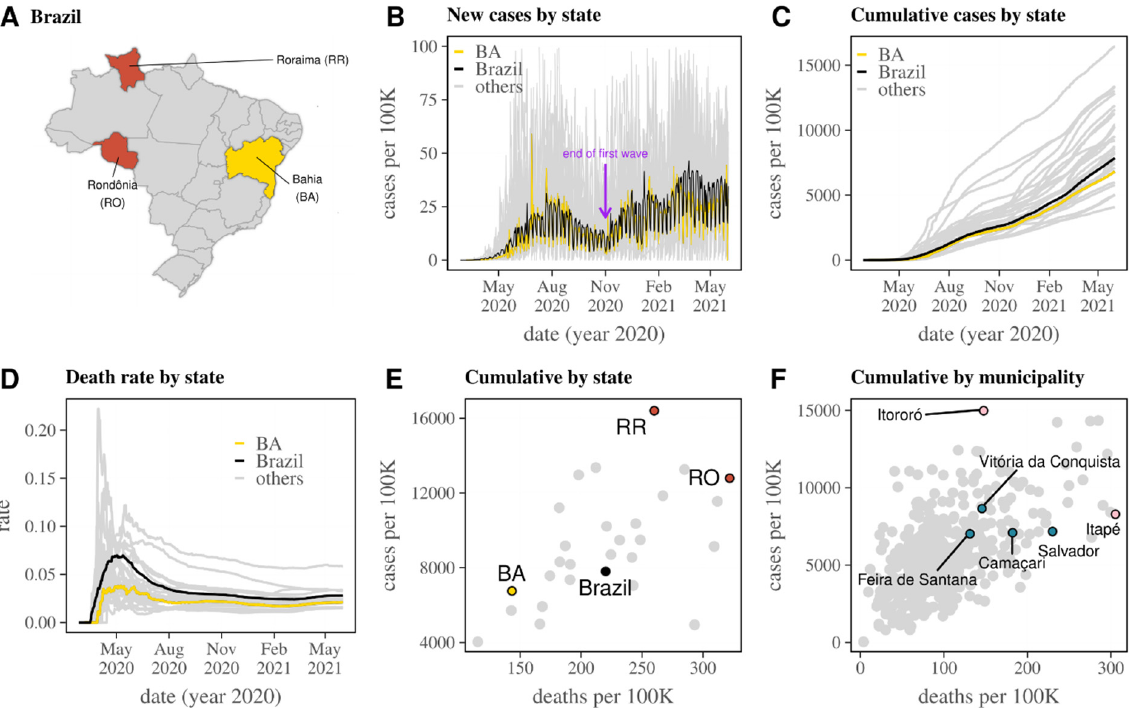
Figure 1. Summary of reported SARS-CoV-2 epidemic in Brazil and Bahia. ( A ) Map of Brazilian states (top), with those relevant for the other panels highlighted with different colors. ( B ) Reported cases per day per state. The purple arrow marks the start of November 2020, when the first trough marks the end of the initial wave of cases. ( C ) Cumulative case incidence (per 100 k residents) per state. ( D ) Death rate (cumulative cases/deaths) per state. ( E ) Cumulative incidence of cases versus deaths per state up to the end of November 2020. ( F ) Cumulative incidence of cases versus deaths in Bahia municipality up to the end of November 2020. ( A – E ) Bahia state (BA) in yellow; Brazil (BR) average in black; Roraima state (RR) and Rondônia (RO) in red; Bahia’s largest four urban cen- ters/municipalities in blue; Bahia municipalities with highest incidences in pink; all other data in grey (states and Bahia municipalities). 3.2. Dynamics of SARS-CoV-2 RT-PCR Testing in Bahia We next explored the dynamics of reported RT-PCR testing in Bahia during the time period of the first wave of SARS-CoV-2 (up to November 2020) using the data subset (i) (see RT-PCR sub-datasets for details). Testing was performed by nine laboratories (Table S2), and while a few laboratories had a regional catchment area, others performed tests across the entire state (Supplementary Figures S4 and S5). Considering the high variation in counts between weekdays and weekends typical of COVID-19 reporting (seen in Figure 1B), we aggregated case and RT-PCR test counts per week. The number of RT-PCR tests per week in Bahia varied significantly between week 9 (end of February) and week 48 (end of November) (Figure 2A). Tests were close to zero up to week 15 (early April), stead- ily increased afterwards, and reached a maximum of 11,088 on week 35 (late August), five weeks after the peak of reported cases. The positive rate was close to one up to week 15 (early April), likely due to the small number of tests performed on individuals presenting with COVID-19 compatible symptoms (Figure 2B). It then reached a minimum of 0.21 on week 17 (mid-to-late April), after which it presented a fluctuating trend up to week 48 (late November). With the exception of its proximity to one before week 16, the positive rate repro- duced an initial wave and a late resurgence in November (Figure 2B). There appeared to be a time lag between the positive rate and the reported cases during the initial wave. Although there was a marked temporary reduction in testing between weeks 45–47 (early to mid-November, Figure 2A), this did not have an impact on the positive rate (Figure 2B).